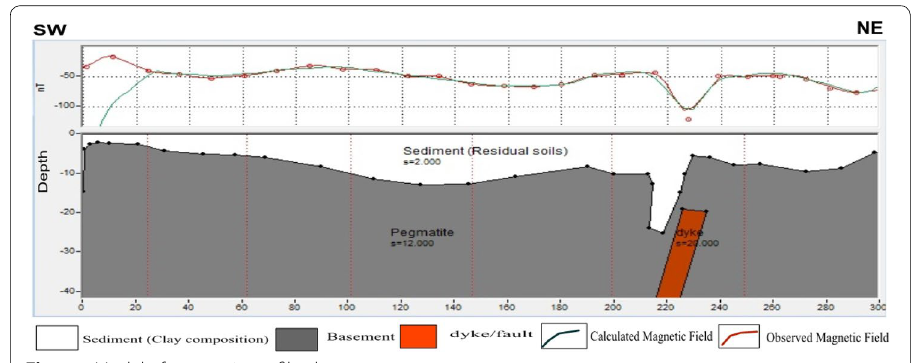
Fig. 17 Model of magnetic profile along traverse